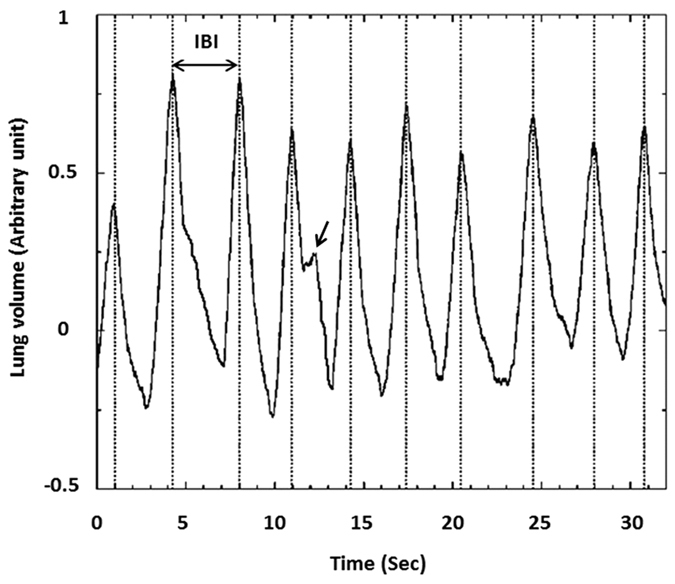
The digitized respiratory signal.